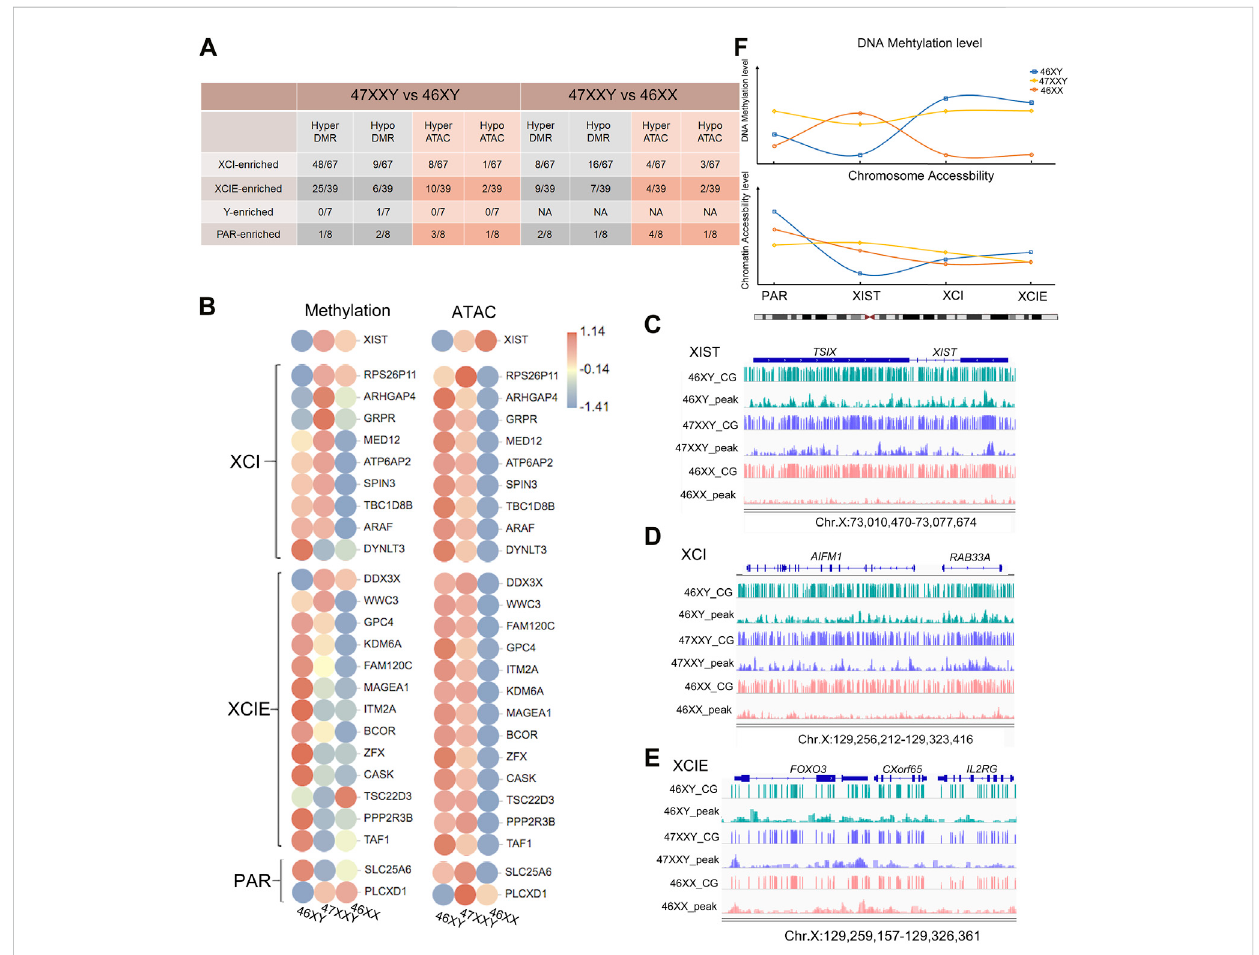
FIGURE 6 The overlapped genes in XIST, XCI, XCIE and PAR region. (A) Statistical data in different functional regions of the Chr.X (XIST, XCI, XCIE and PAR). (B) The heatmap of XIST, XCI, XCIE and PAR genes in WGBS and ATAC-seq. Each circle represents the normalized methylation level/open ability in each sample in 46XY, 46XX and 47XXY. The colors from red, white to blue mean the methylation levels from high, median to low (1.14, − 0.14 to − 1.41). (C – E) IGV mapof XIST, XCI and XCIE genesin WGBS and ATAC-seq. The bluechannel represents 46XY, and thepurple channel represents 47XXY, and the pink chanel represents the 46XX. (F) The mean methylation level of XIST, XCI, XCIE and PAR genes. The blue hollow square represents 46XY, the yellow hollow rhombus represents 47XXY and the orange hollow circle represents 46XX. The corresponding lines represent the methy trend in XIST, XCI, XCIE and PAR